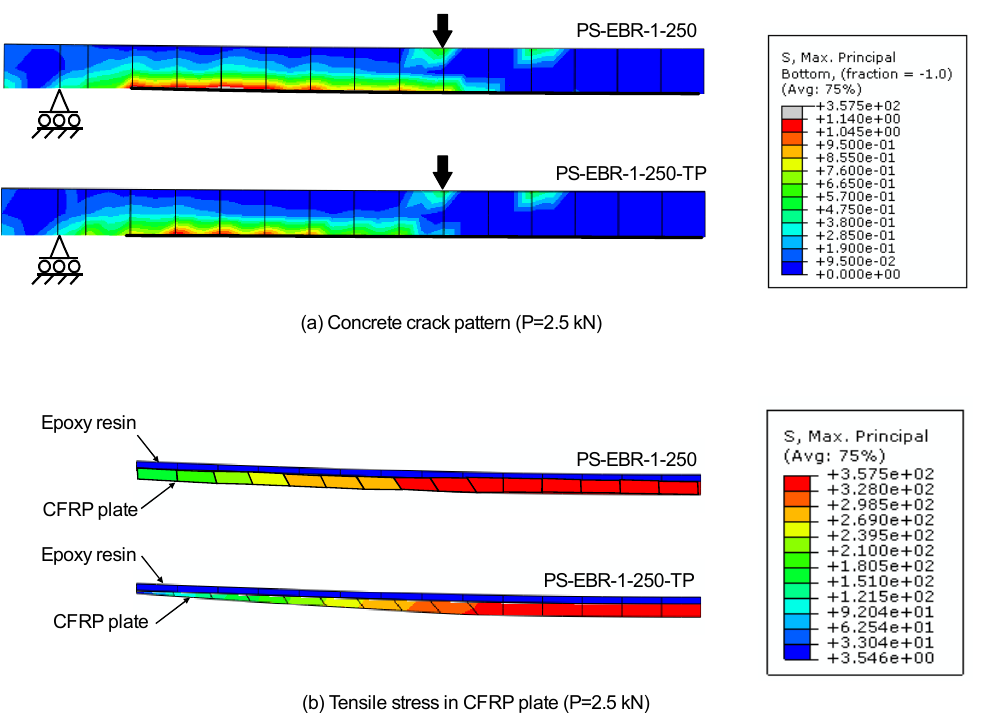
Figure 10. Comparison of principal tensile stress at load P = 2.5 kN of slabs without (PS-EBR-250) and with tapering (PS-EBR-250-TP), ( a ) stress along CFRP sheets and ( b ) detail of tensile stresses at end anchorage of CFRP sheets.